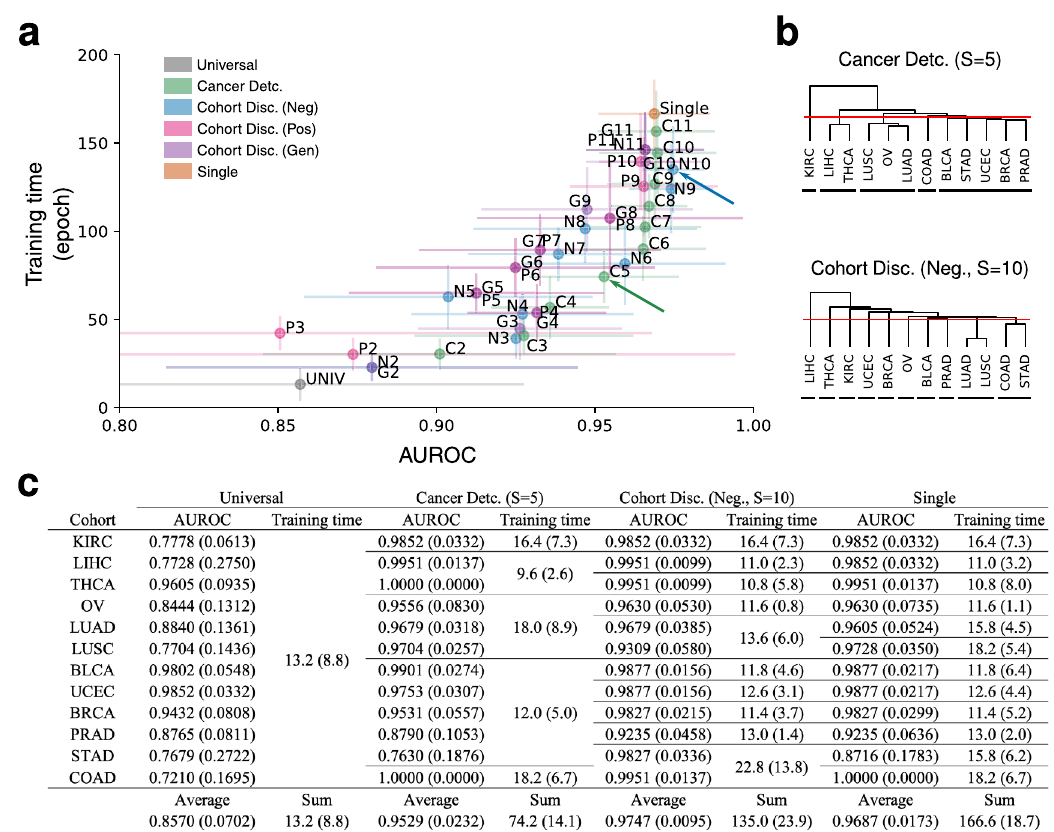
Figure 7. ( a ) AUROC scores and training time of universal model, single models, and super-cohort models on the test set of each cohort. Lines represent 95% confidence intervals. Superscripts indicate the models referenced to aggregate cohorts, and S is the number of super-cohorts. C, T C ; N, T D n , P, T D p ; G, T D g (e.g., C5: T C ( S = 5 ) ). ( b ) Super-cohort configuration of the super-cohort T C ( S = 5 ) incurring least training time among those that performed better than the 95% lower CI of cohort-specific models (top) and super cohort T D n ( S = 10 ) which resulted in best performance (bottom). Hierarchy level (red lines) and cohorts included in super cohorts (black lines) are shown. ( c ) Comparison of naive combinations (universal model and single models) and super-cohort models indicated by arrows in ( a ). See Supplementary Data Table s2 for details of